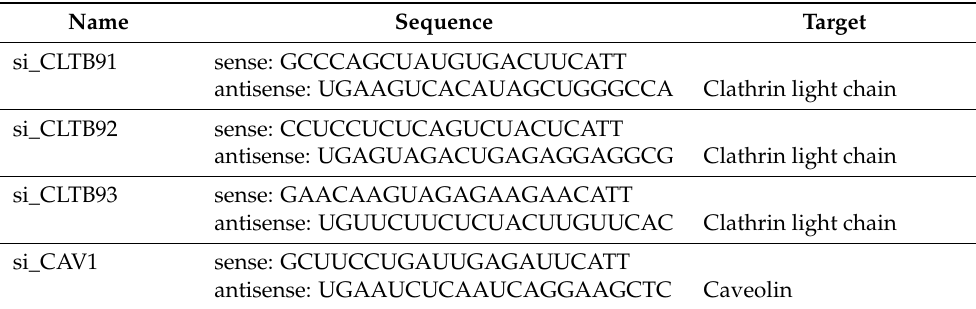
Table 1. siRNA sequences for knockdown of clathrin light chain and